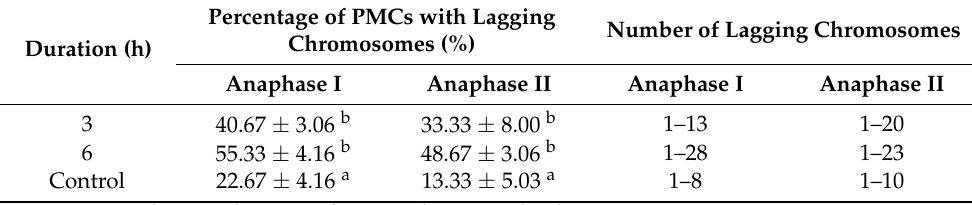
Table 2. Formation of lagging chromosomes induced by high temperature exposure in P. canescens